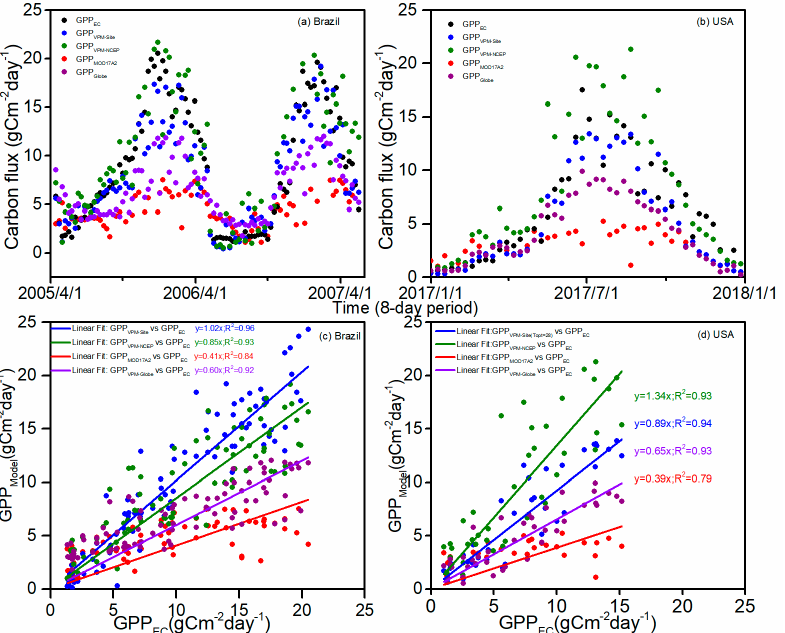
Figure 10. A comparison of the seasonal variation in the estimated GPP EC and predicted GPP VPM-Site , GPP VPM-NCEP , GPP MOD17A2 , and GPP VPM-Globe at the two sugarcane EC tower sites. ( a ) and ( c ), Brazil site, 2005 − 2007; ( b ) and ( d ), Louisiana, USA site, 2017.